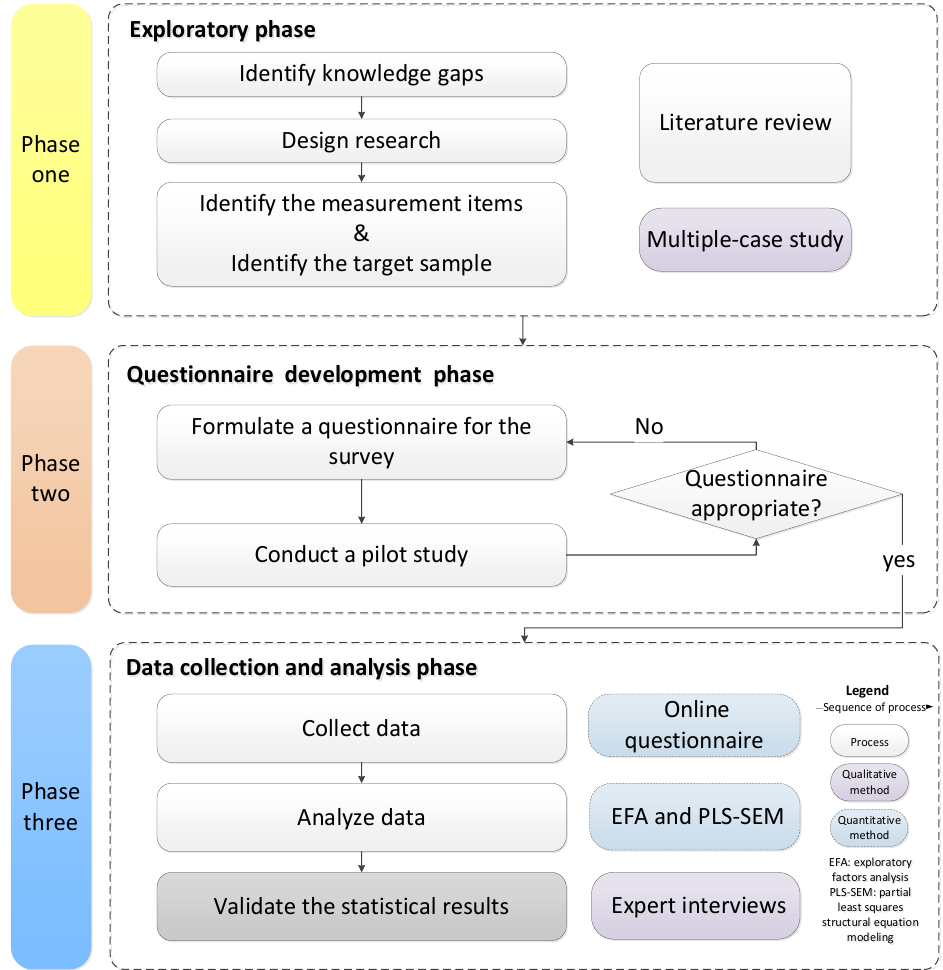
Figure 2. Three phases of the research